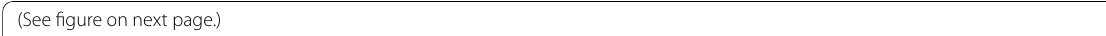
(See figure on next Fig. 5 Transcriptional activity of genes participating in the nutrient digestion and absorption of Wocan Alviniconcha marisindica . Heat map of transcriptional activity of genes that a encode specialised transport proteins and various hydrolases, including proteases, glycoside hydrolase, and peptidoglycan recognition proteins (PGRPs) in the foot, neck, mantle, digestive gland (DG), intestine and gill tissues and are involved in b gut microbial exo‑hydrolase biosynthesis for intestinal nutrient digestion in A. marisindica